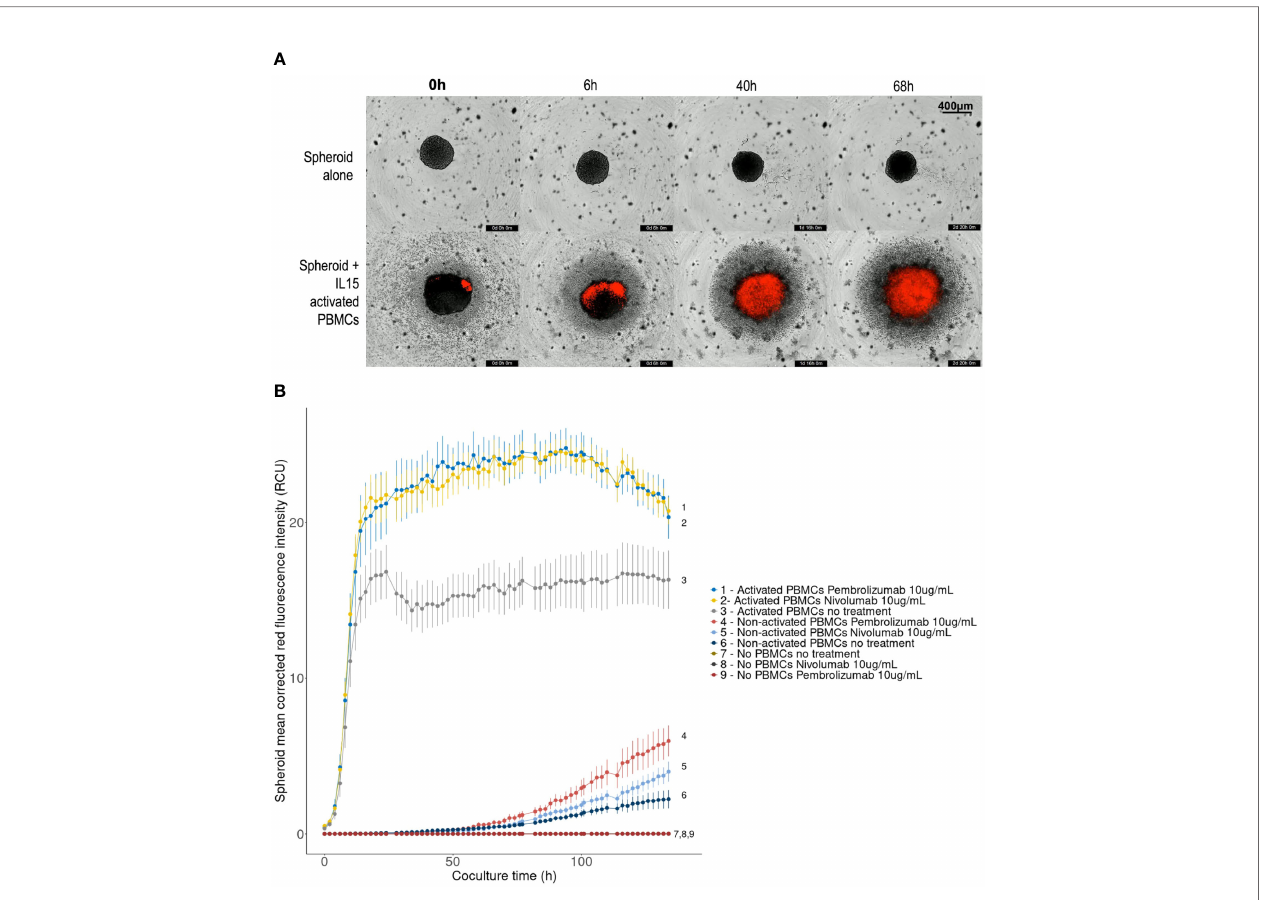
FIGURE 6 | Effect of PD-1 blockade on spheroid destruction by IL-15 activated allogeneic PBMCs. 10,000-cell RCC7 spheroids were cultured alone or co-cultured with activated or non-activated PBMCs for 5 days, in the presence or absence of nivolumab or pembrolizumab. The wells were imaged every 2 hours with the Incucyte S2 system. Propidium Iodide staining was used to track cell death. (A) Representative 4× bright fi eld images with superimposed red fl uorescence (Propidium Iodide), background level was set by fi xing control spheroid red fl uorescence to zero. (B) Linechart of spheroid red fl uorescence measurement (Red Calibrated Unit) over time as calculated by the Incucyte S2 system in the given conditions. Means of 10-plicates, representative results out of 3 experiments. Error bars represent the Standard Error of the means, digits correspond to